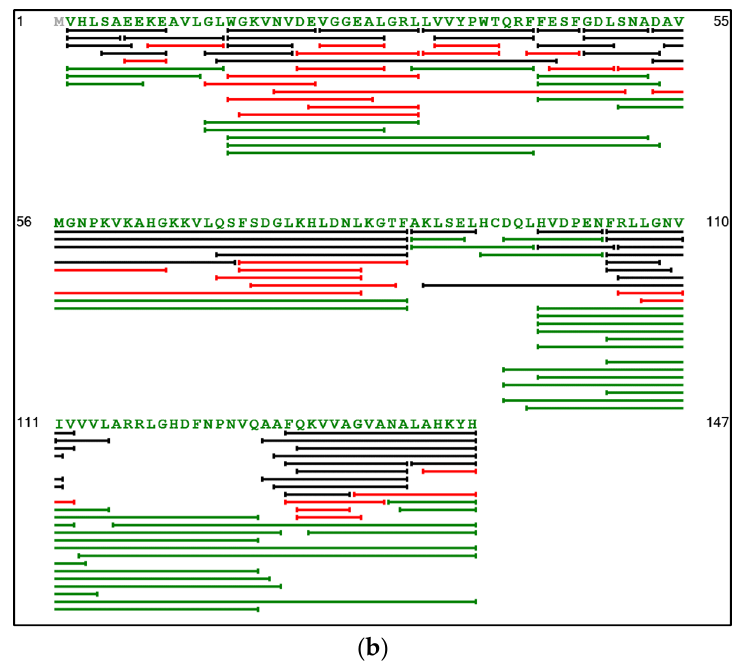
Figure 3. Peptide mapping comparisons of the alpha chain of porcine hemoglobin ( a ) and the beta chain of porcine hemoglobin ( b ). Green: peptides only present in the porcine cruor hydrolysate after 30 min; Red: peptides only present in the porcine hemoglobin hydrolysate after 180 min; Black: Peptides in common between hydrolysates at 30 min and 180 min.